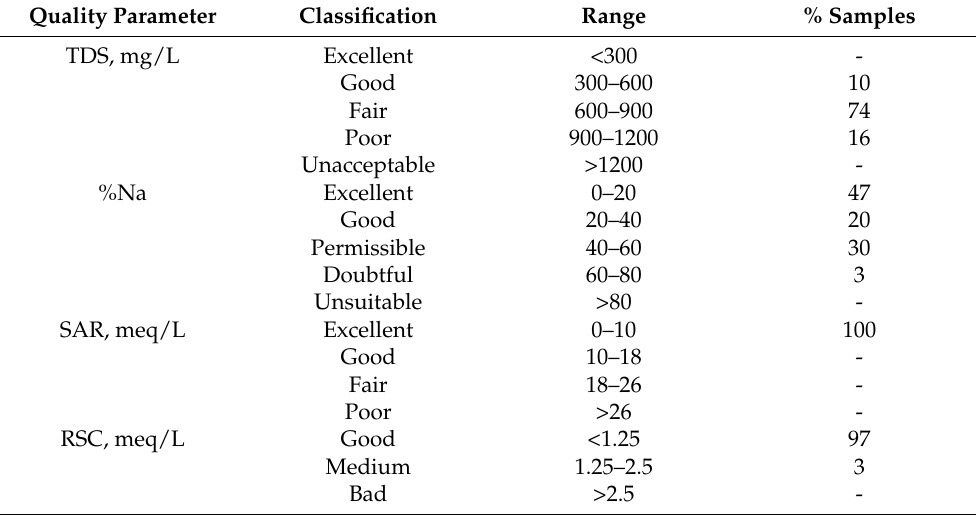
Table 6. Groundwater classification for human consumption and agriculture